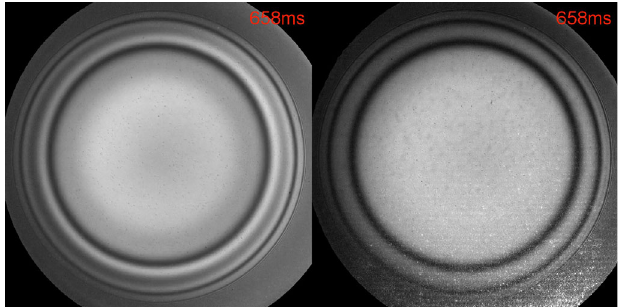
Movie 5. Bottom views of the tracer particles ’ motions in the oil film (left) and the droplet (right)